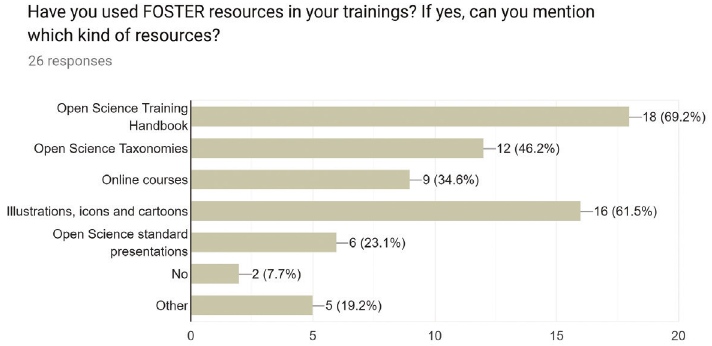
Fig. 3: Responses to bootcamp feedback